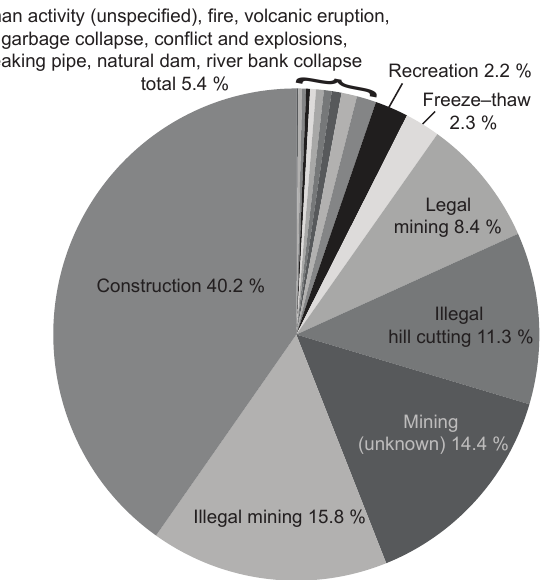
Figure 7. Distribution of triggers of NSNR landslide events (770